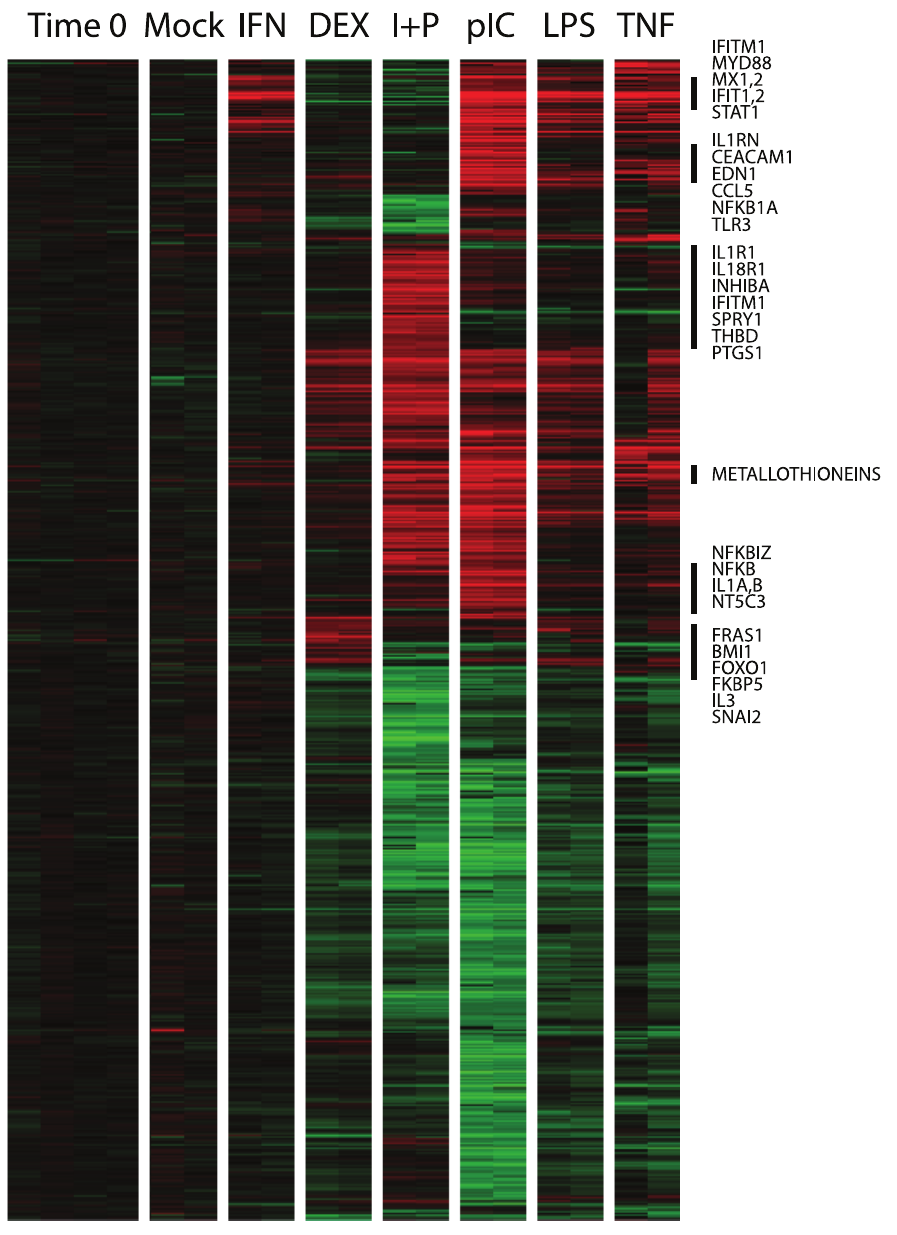
Figure 2. Stimulation of primary human fibroblasts. Fibroblasts were treated for 24 hours with each of 6 different molecular stimuli, or with a mock treatment. 3754 genes whose expression level increased or decreased by at least a factor of three in response to one or more of the treatments are included in this display; each column represents the changes in abundance of transcripts from each of these genes after 24 hours of treatment with one of the agents. For each molecular stimulus, results from two replicate treatments are shown. The genes were hierarchically clustered, and their expression represented by a color scale as in Figure 1. The brightest red and green colors in this display correspond to increases or decreases in transcript abundance by factors of at least 32 relative to time zero. 0hr=pre-stimulation timepoint, all other timepoints taken 24 hours post stimulation; mock (PBS), IFN a =Interferon alpha, TNF-alpha=tumor necrosis factor alpha, I + P=ionomycin and phorbal 12-myristate 13-acetate, poly(I-C)=polyinosinic-polycytidylic acid, LPS= Escherichia coli 055:B5 lipopolysaccharide, Dex=Dexamethasone. Names of a few selected genes from clusters with distinctive patterns of induction by one or more of these agents are indicated to the right of the corresponding clusters, marked by the vertical black lines. For a comprehensive, browseable view of the transcript profiles characteristic of each response see the supporting information. The complete raw data from this experiment are available at: www.smd.stanford.edu or the GEO database (accession number GSE24125).